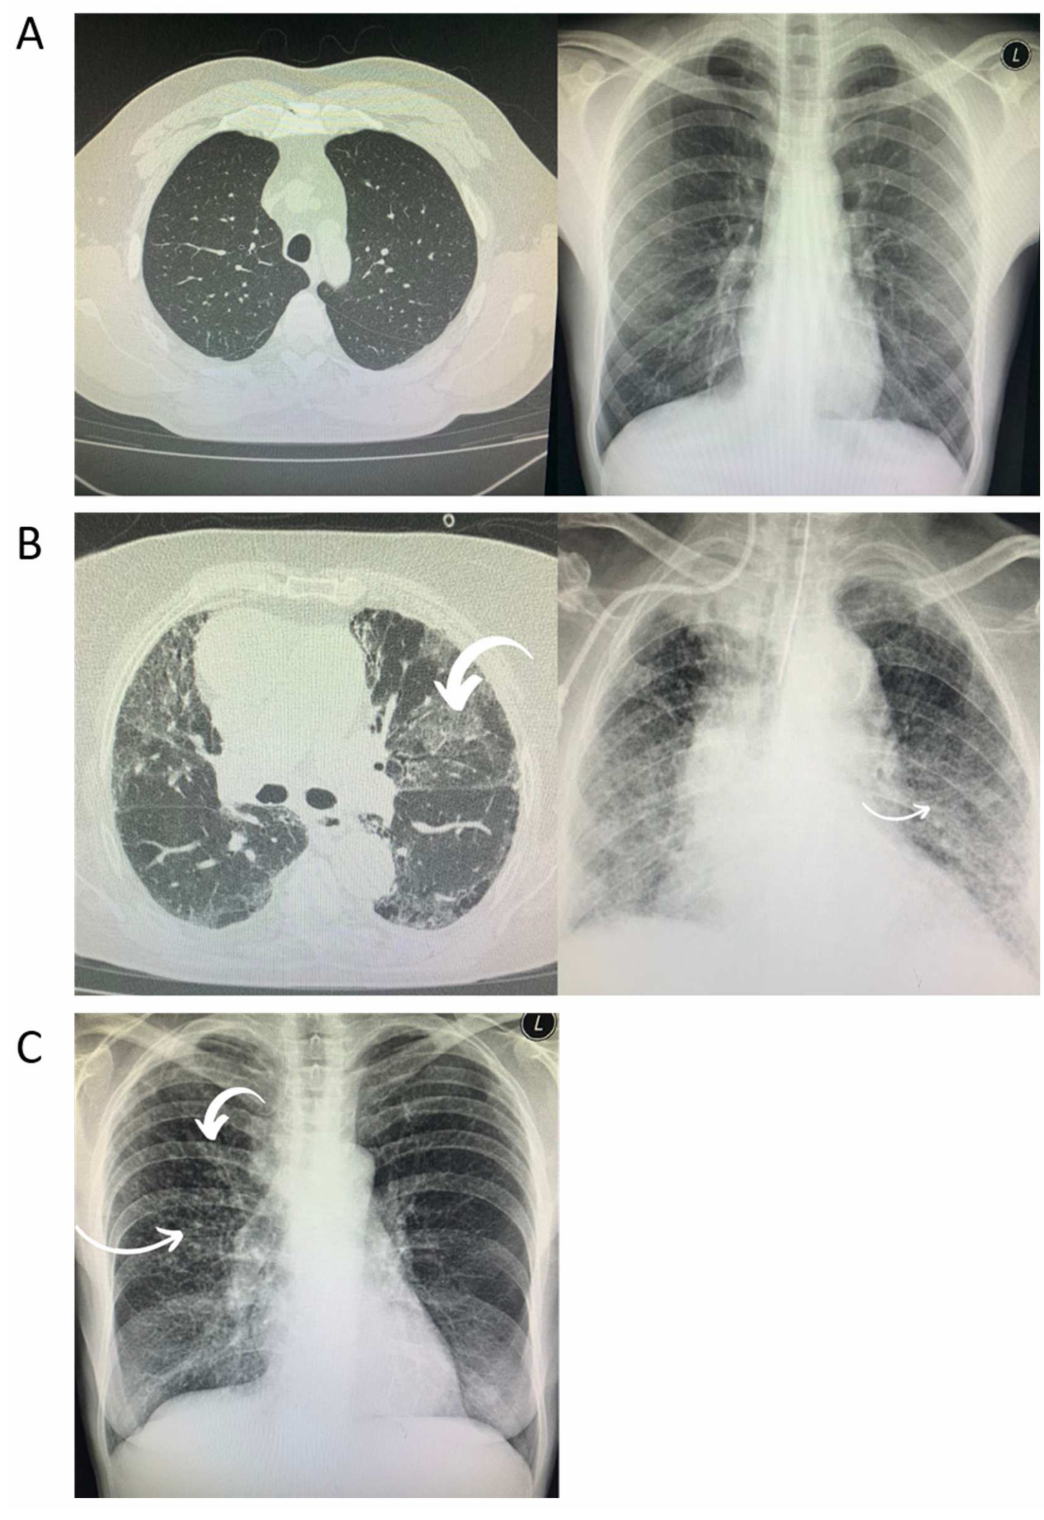
Figure 1. Radiological chest imaging of HIV-positive patients with COVID-19. ( A ) These images depict no radiological changes. ( B ) Typical radiological changes (bilateral and peripheral ground glass and consolidated opacities). ( C ) Atypical radiological changes (diffuse nodular